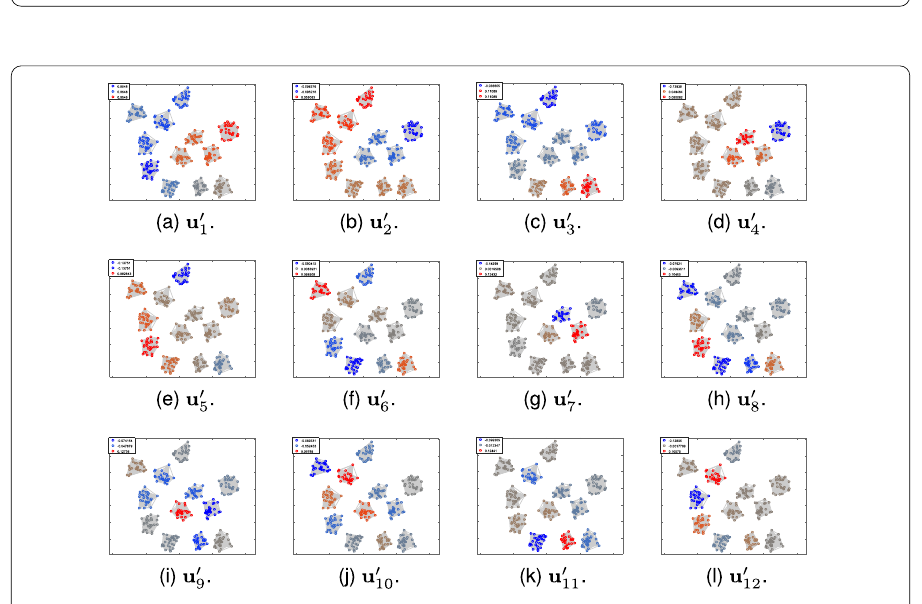
} Figure 8 The basis { u (cid:4) j =1,2, ... , q of the null-space of L visualized as distributions over the vertices (red is j positive, blue is negative). Compare this with Figs.